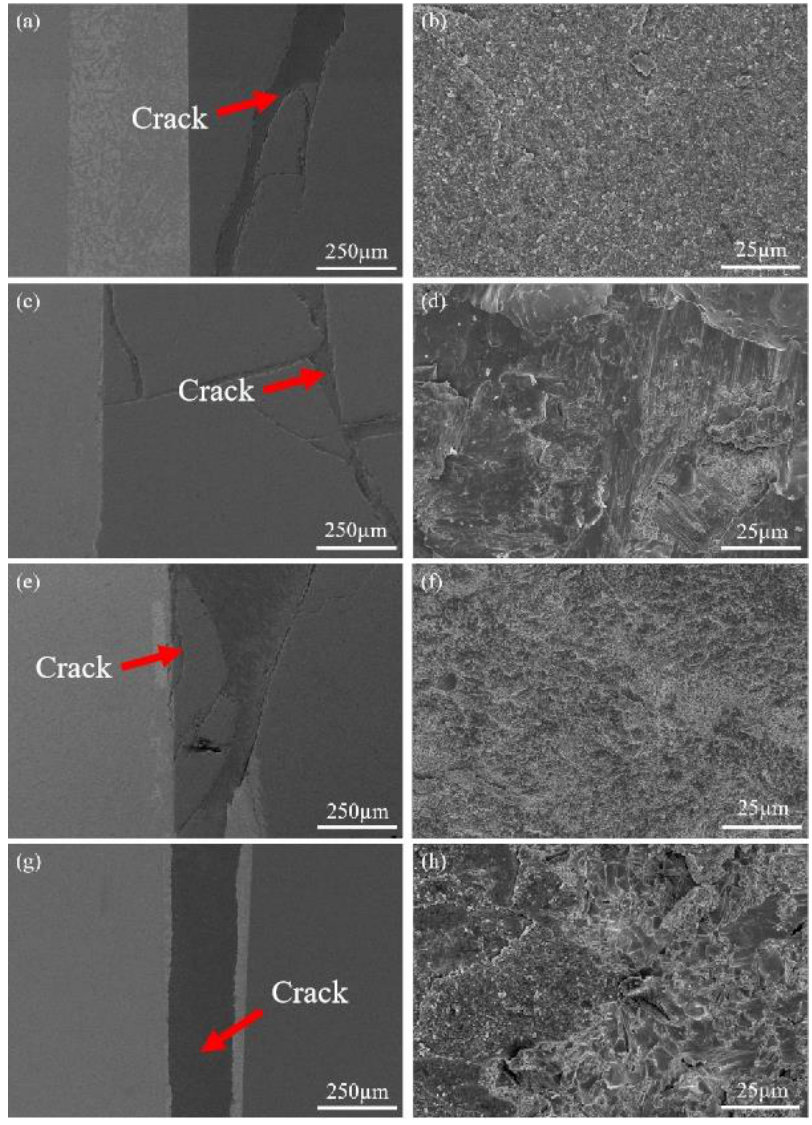
Figure 12. Fracture path and morphology of the GH4169/Si 3 N 4 joints at different temperatures: ( a ), ( b ) 820 °C; ( c , d ) 850 °C; ( e , f ) 880 °C; and ( g , h ) 910 °C. ( a , b ) 820 ◦ C; ( c , d ) 850 ◦ C; ( e , f ) 880 ◦ C; and ( g , h ) 910 ◦